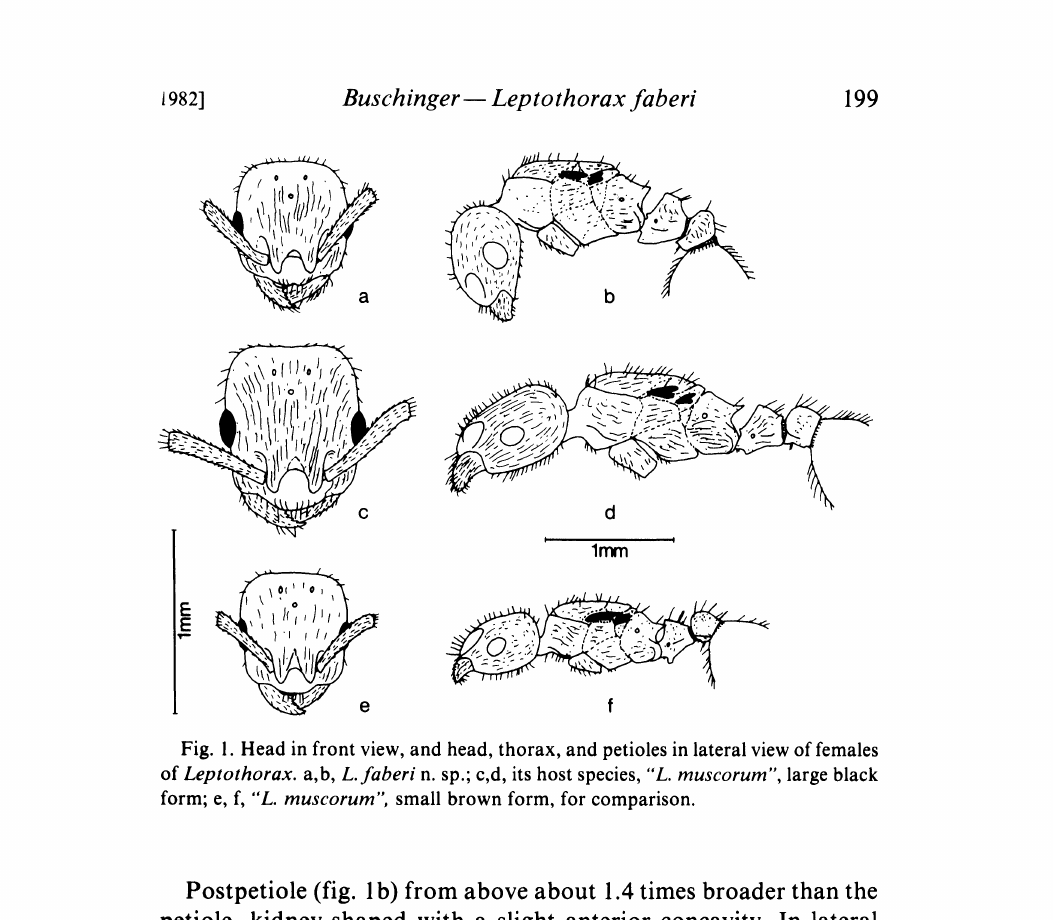
Fig. 1. Head in front view, and head, thorax, and petioles in lateral view of females of Leptothorax. a,b, L. faberi n. sp.; c,d, its host species, "L. muscorum", large black form; e, f, "L. muscorum’; small brown form, for